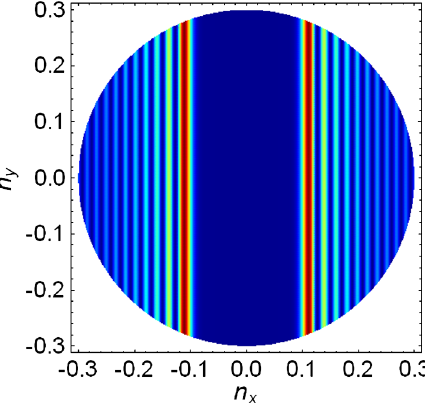
FIG. 2. Density plot of the function J 2 h ð h ß an x Þ in the n x , n y